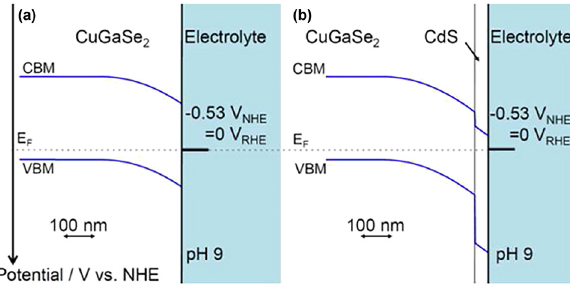
Figure 9: Calculated band alignment at the solid - electrolyte inter - faces for ( a ) CuGaSe 2 and ( b ) CdS/CGSe electrodes. Reprinted with permission from ref. [ 23 ] . ©2013 American Chemical Society.